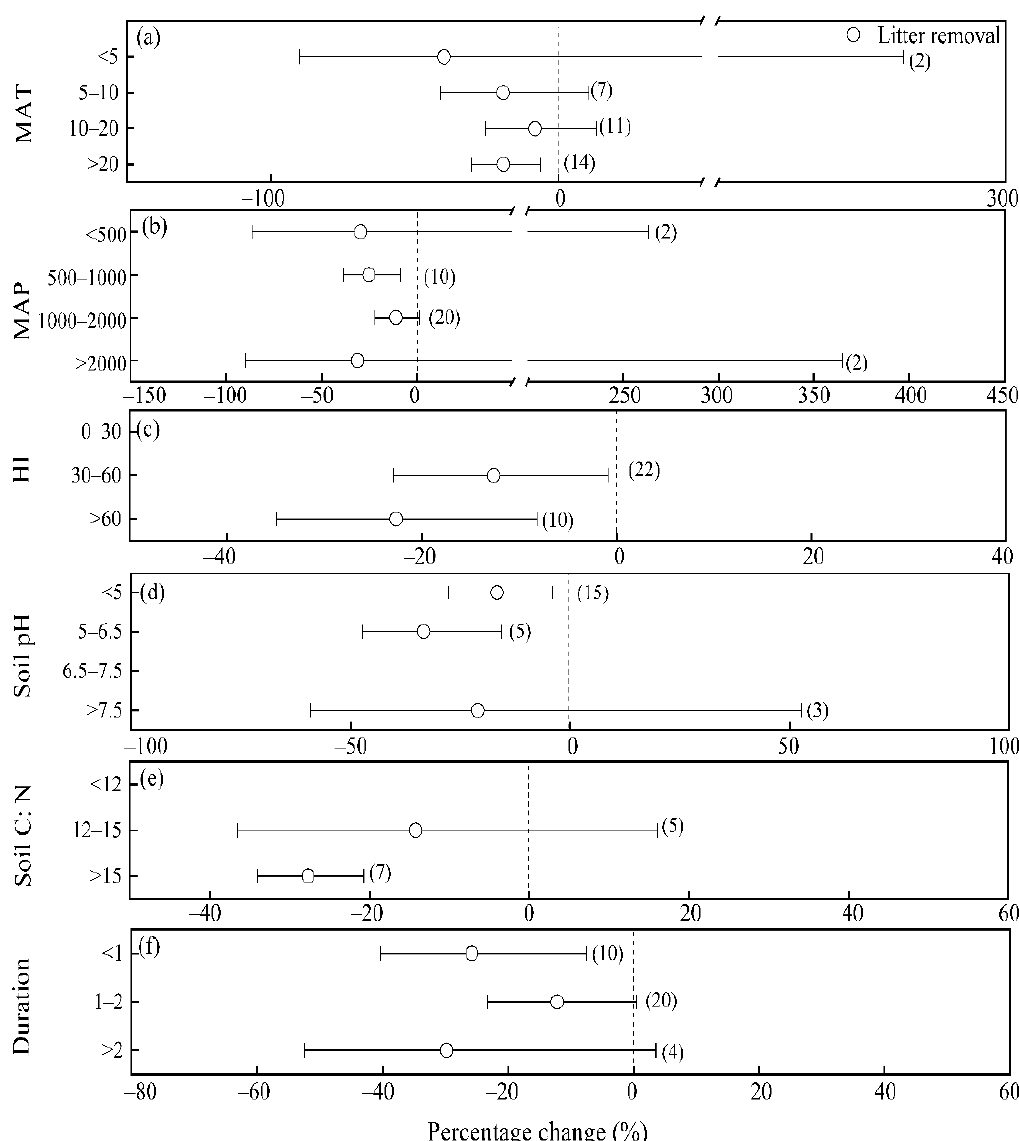
Figure 2. Effects of litter removal and a doubling of litter inputs on soil N 2 O fluxes for different values of MAT (( a ), mean average temperature), MAP (( b ), mean average precipitation), HI (( c ), humidity index), soil pH ( d ), soil C: N ratio ( e ), experimental duration ( f ), and litter amount ( g ). Horizontal lines represent the 95% confidence intervals (CI) and the number of observations is included in parentheses. The means were considered significantly different if their 95% CI did not overlap with zero.